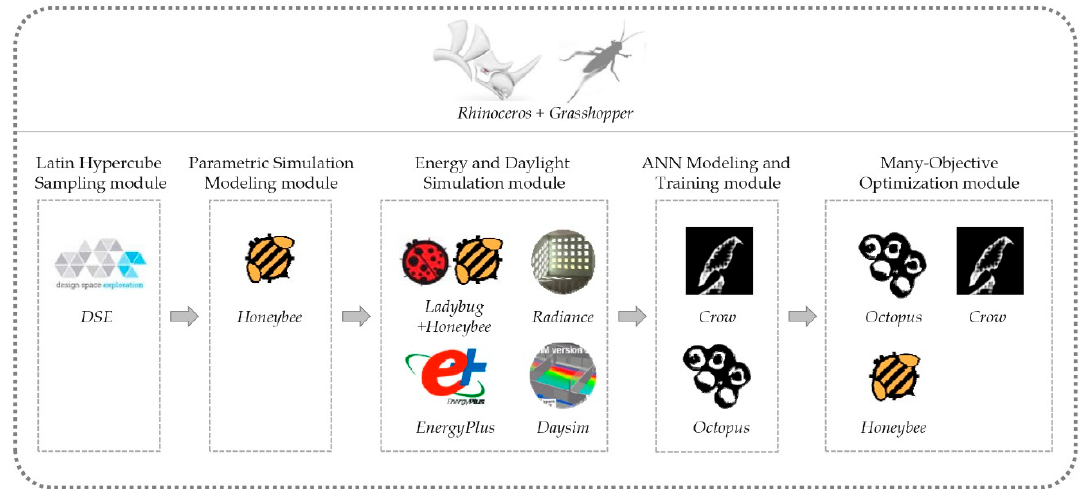
Figure 2. The software and plug-ins coupled in the optimization design model.